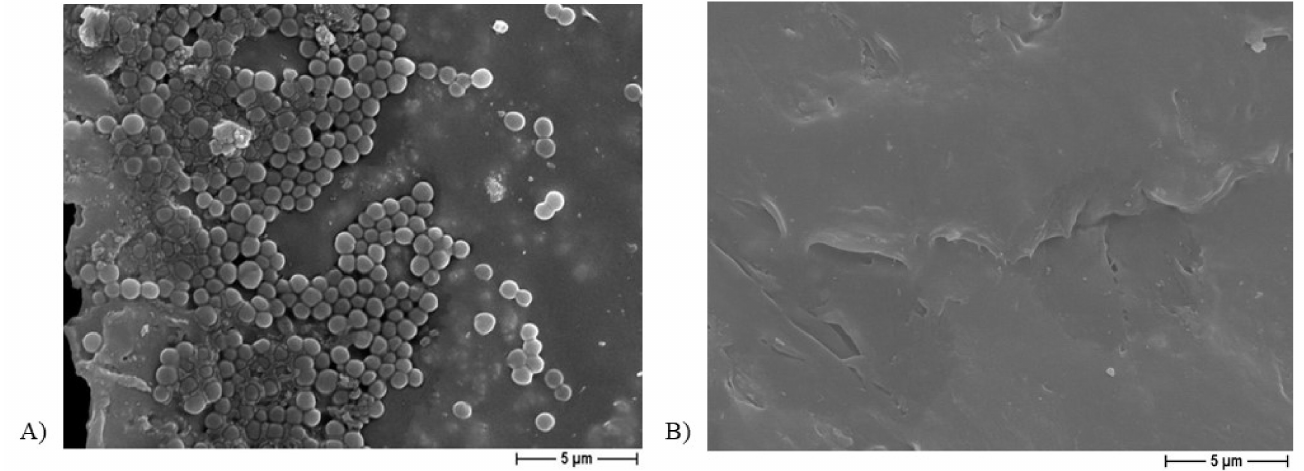
Figure 8. Representative FESEM micrograph of non-sonicated PCL-based scaffolds ( A ) and Ag-added PCL-based scaffolds ( B ), obtained by using NaCl salt as a template, at 5000 ×